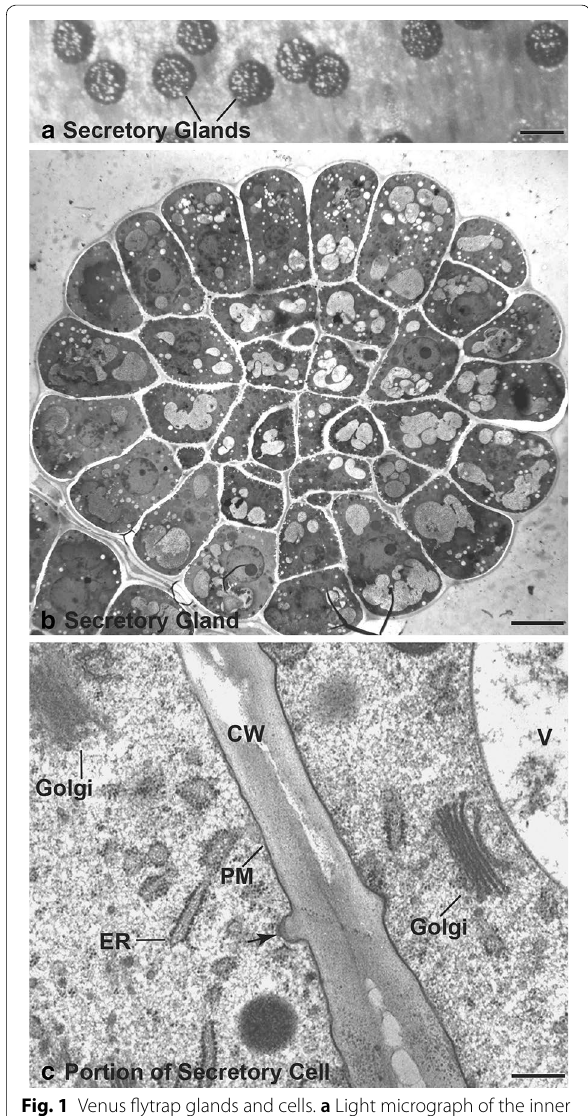
Fig. 1 Venus flytrap glands and cells. a Light micrograph of the inner surface of a Venus flytrap snap lobe showing the stalked, digestive enzyme-secreting gland cells. Bar 100 µm. b Electron micrograph of a thin section through a digestive enzyme-producing gland preserved by high pressure freezing and freeze-substitution methods. The section plane is parallel to the lobe surface and shows the organization of the ~ 32 secretory cells within the gland. Bar 10 µm. c Higher magnification image of two secretory cells in a high pressure frozen/freeze substituted gland. Note the close apposition of the plasma membranes (PM) to the cell wall (CW) which is marked by cell surface area increasing protuberances (arrow). Endoplasmic reticulum (ER), vacuole (V). Bar 0.5